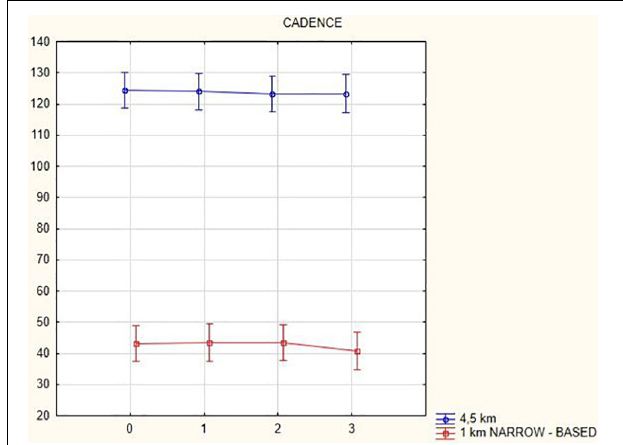
FIGURE 4 | Cadence in the gait at a speed 4.5 km/h and in the narrow-based gait at a speed of 1